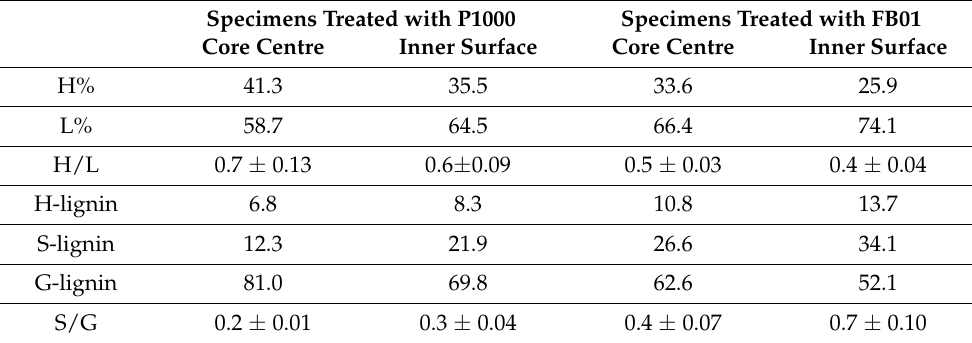
Table 8. Percentage composition of pine determined by Py-GC/MS. The average values were obtained from four specimens analysed for each P1000 and FB01. Here, the percentages are based on total pyrolysis products identified, including those from the impregnating materials. Specimens Treated with P1000 Specimens Treated with FB01 Core Centre Inner Surface Core